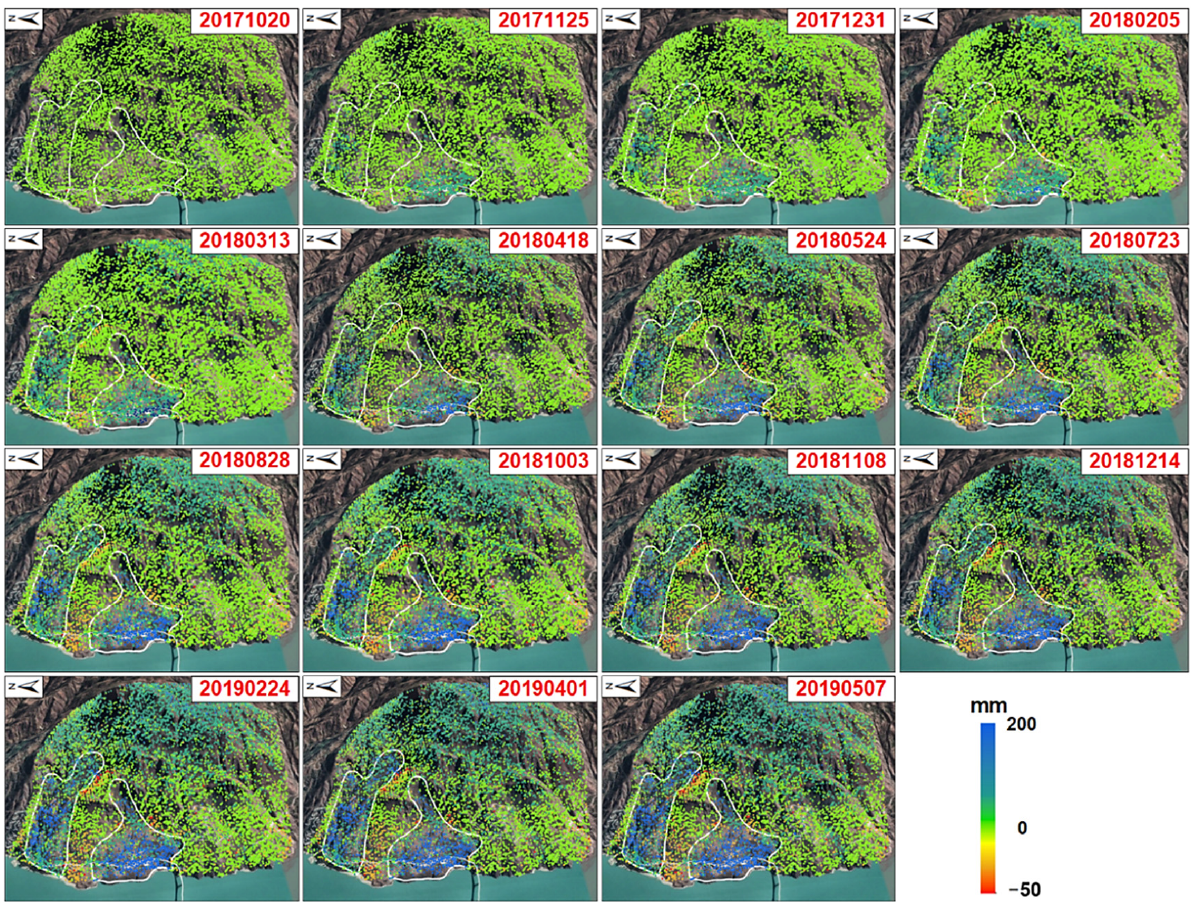
Figure 13. Cumulative deformation from October 2017 to May 2019 of the XJ landslide.